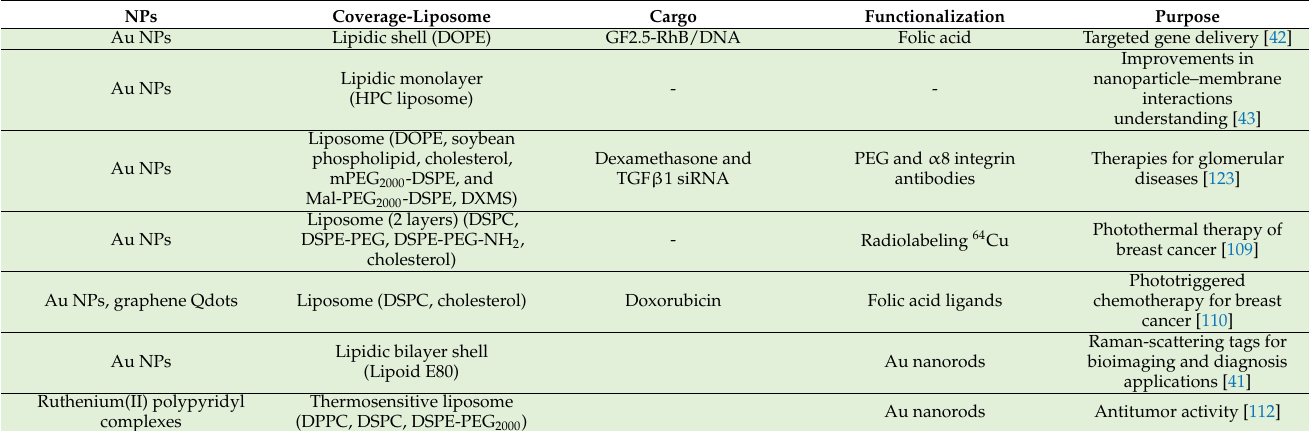
Table 2. In vivo studies on solid-state nanoparticles enclosed in lipidic-based shell or extracellular vesicles. Green background color refers to artificial liposomes and pink refers to extracellular vesicles. To the authors knowledge, no data are reported in the literature referred to engineered, hybrid or artificial extracellular